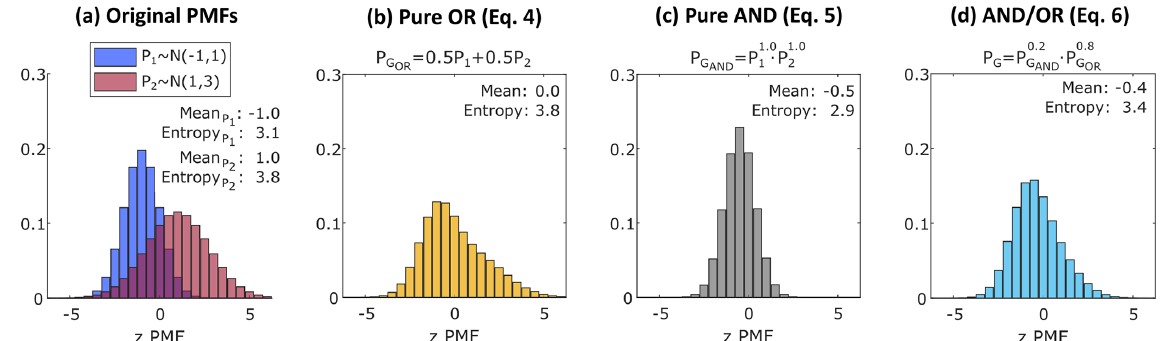
Figure 3. Examples of the different pooling operators. Illustration of (a) normal PMFs N(µ , σ 2 ) to be combined, (b) linear aggregation of (a) – Eq. (4), (c) log-linear aggregation of (a) – Eq. (5), and (d) log-linear aggregation of (b) and (c) – Eq.